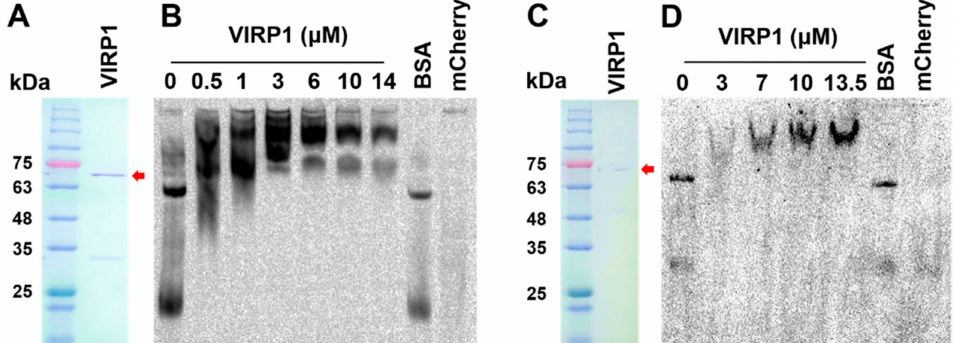
Figure 2. Purification of viroid RNA-binding protein 1 (VIRP1) and its binding to citrus exocortis viroid (CEVd). ( A ) Ni-NTA-purified VIRP1. ( B ) Electrophoretic Mobility-Shift Assay (EMSA) of CEVd with Ni-NTA-purified VIRP1. The CEVd concentration was 50 nM, and the concentrations of bovine serum albumin (BSA) and mCherry were 10.5 µ M and 14 µ M, respectively. ( C ) Size- fractionated VIRP1 after Ni-NTA purification. ( D ) EMSA of CEVd with size-fractionated VIRP1. µ M, respectively. CEVd was labeled with digoxigenin (Dig). mCherry indicates mCherry::mCherry protein with 6xHis tag. Arrows indicate VIRP1. ( A , C ): Coomassie-stained SDS-PAGE gels. ( B , D ): The non-denaturing polyacrylamide gel, as described in the Materials and Methods. Bands of CEVd observed during EMSA in previous reports